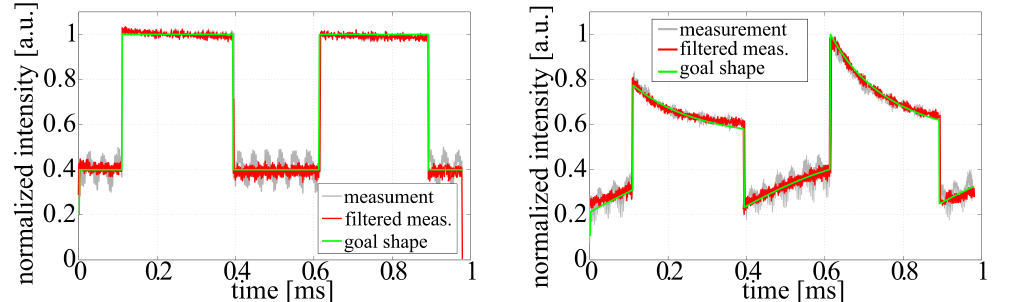
Figure 5. ( Left ) Input pulse train with alternating amplitude; ( right ) resulting output pulse train after